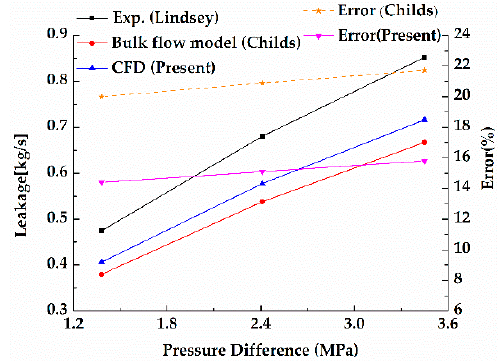
Figure 9. Leakage as a function of pressure difference.